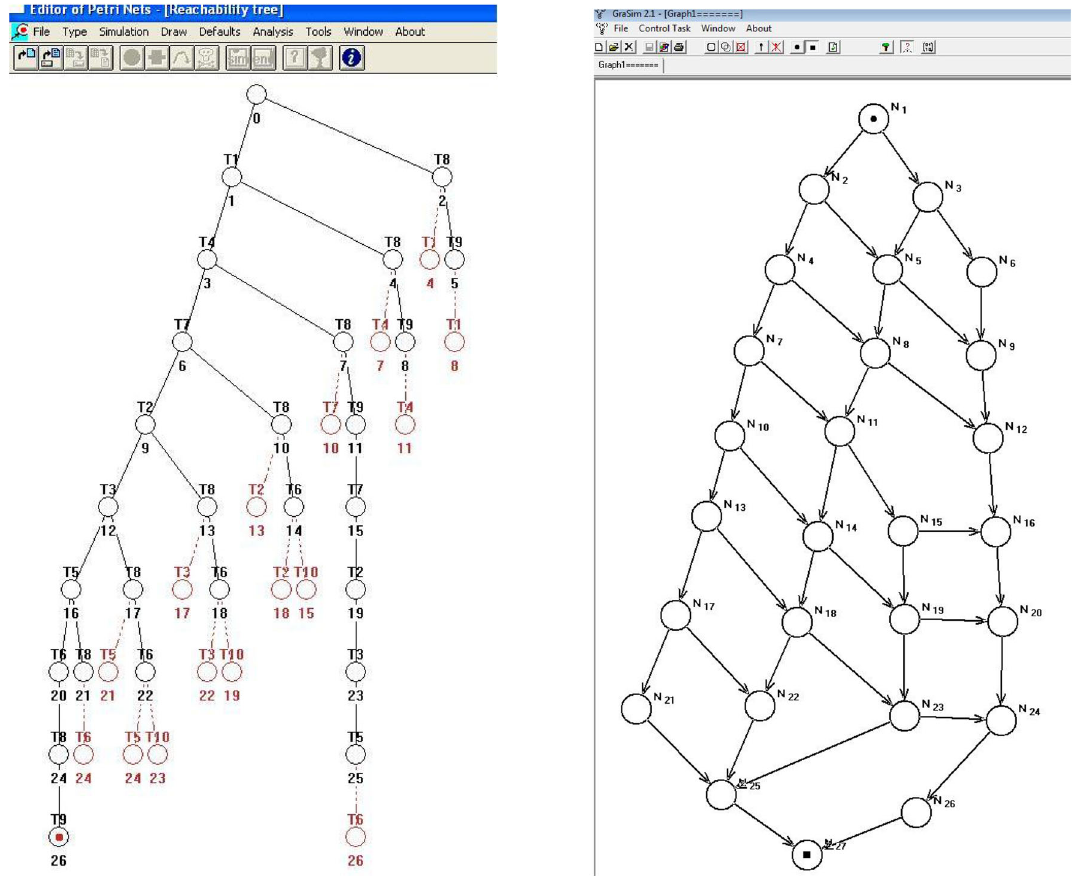
Fig. 9 The RT of the recovered system with removed deadlock by means of the supervisor (left) and the corresponding RG